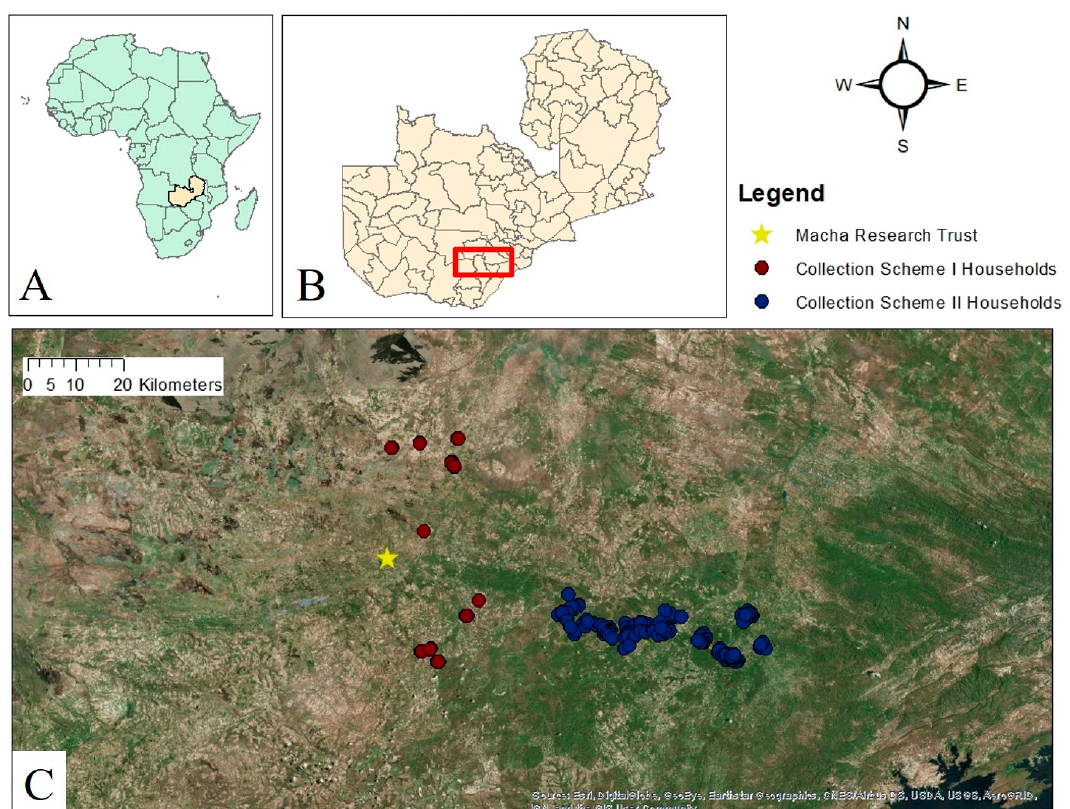
Figure 1. ( A ) Map of Africa; Zambia highlighted in light yellow. ( B ) Map of Zambia and its districts; study area is enclosed in red. ( C ) Satellite imagery of study area delineating households included in this study. Households are colored according to the collection scheme under which they were sampled.